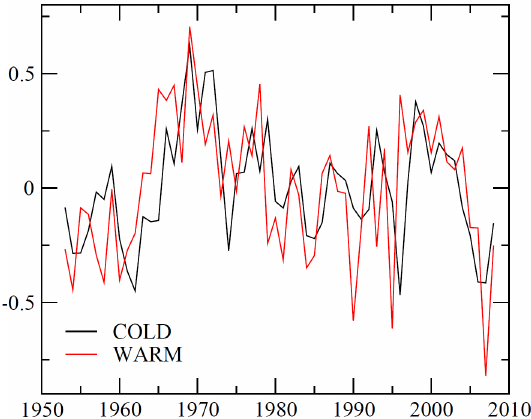
Fig. 6. Detrended Northern Hemisphere sea ice area anomalies during 1953–2008, in 10 6 km 2 (HadISST1.1 data) for the cold (November–April) and warm (May–October) half of the year.